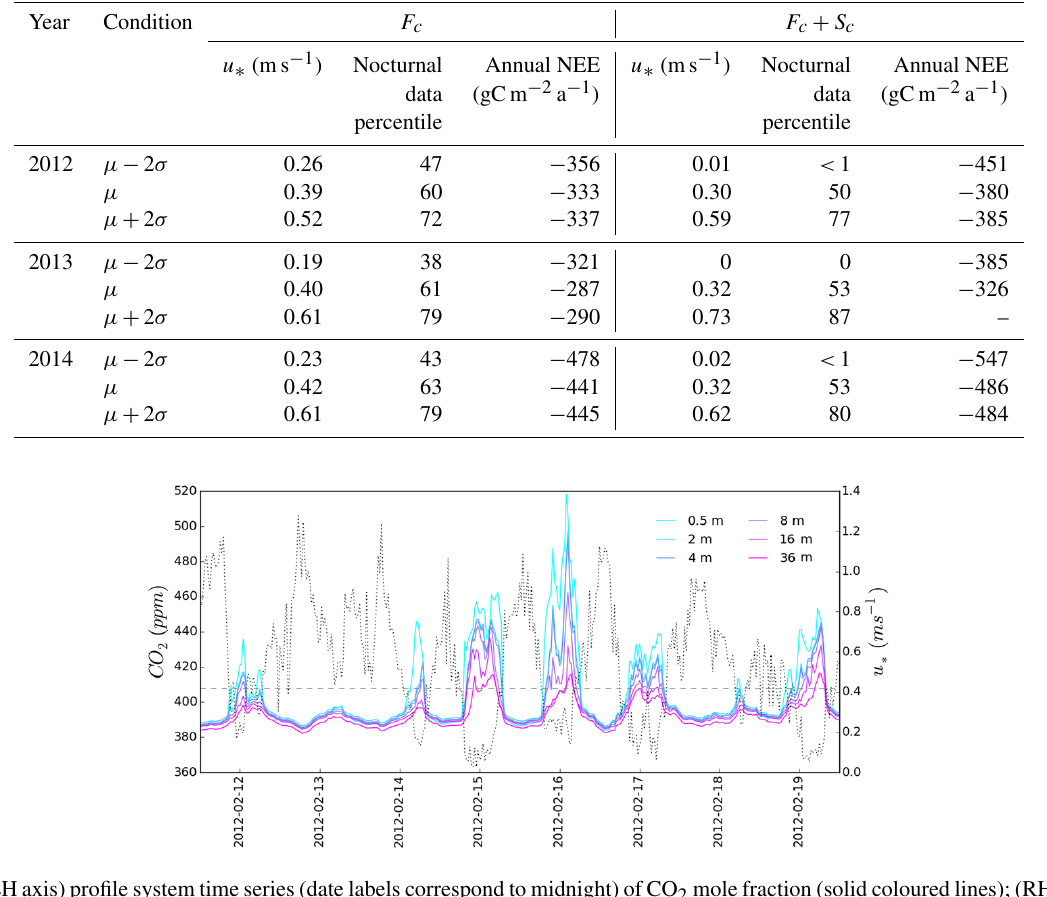
Figure 6. (LH axis) profile system time series (date labels correspond to midnight) of CO 2 mole fraction (solid coloured lines); (RH axis) time series of u ∗ measured at 36m (dotted grey line). Note that horizontal dashed line marks u ∗ th for F c